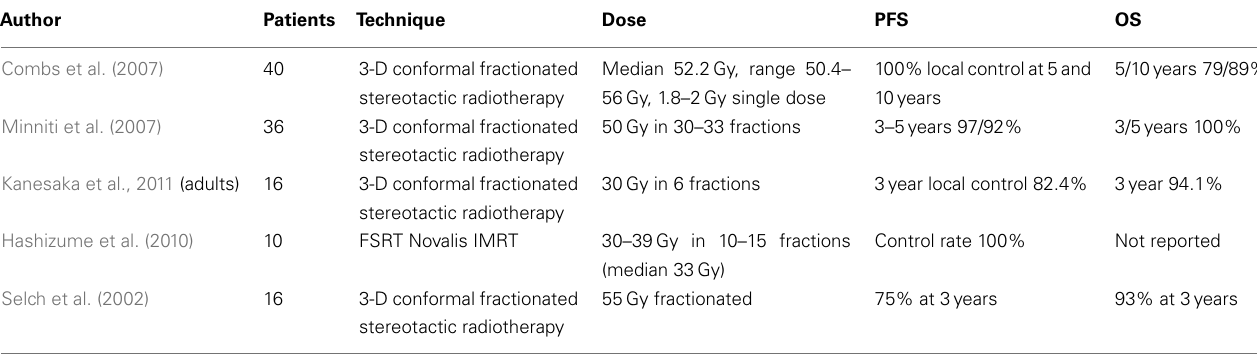
Table 2 | Results after modern external fractionated radiotherapy techniques.